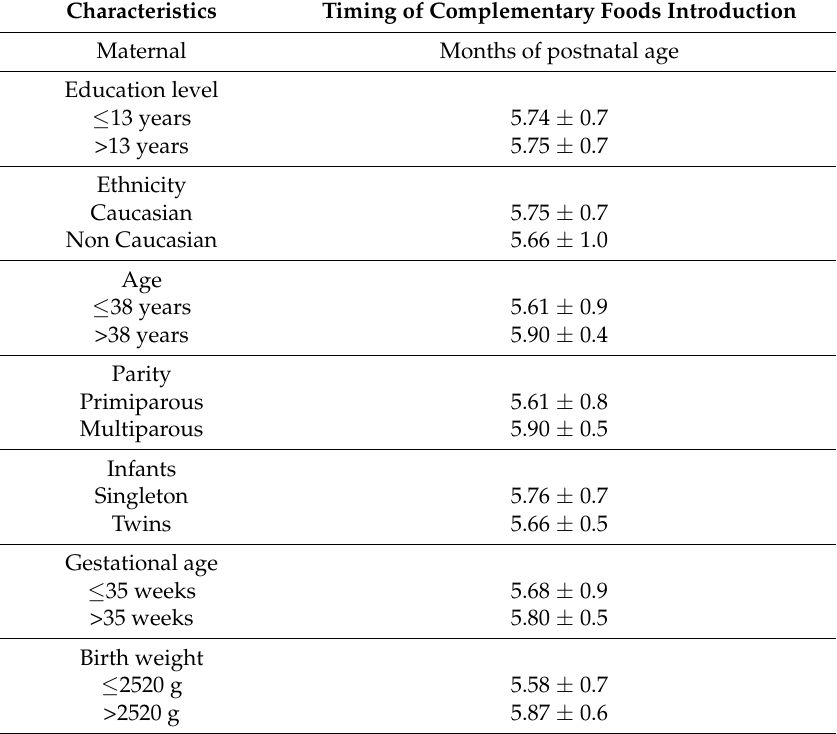
Table 2. Mean postnatal age at complementary foods introduction according to maternal and infant characteristics and type of complementary foods first